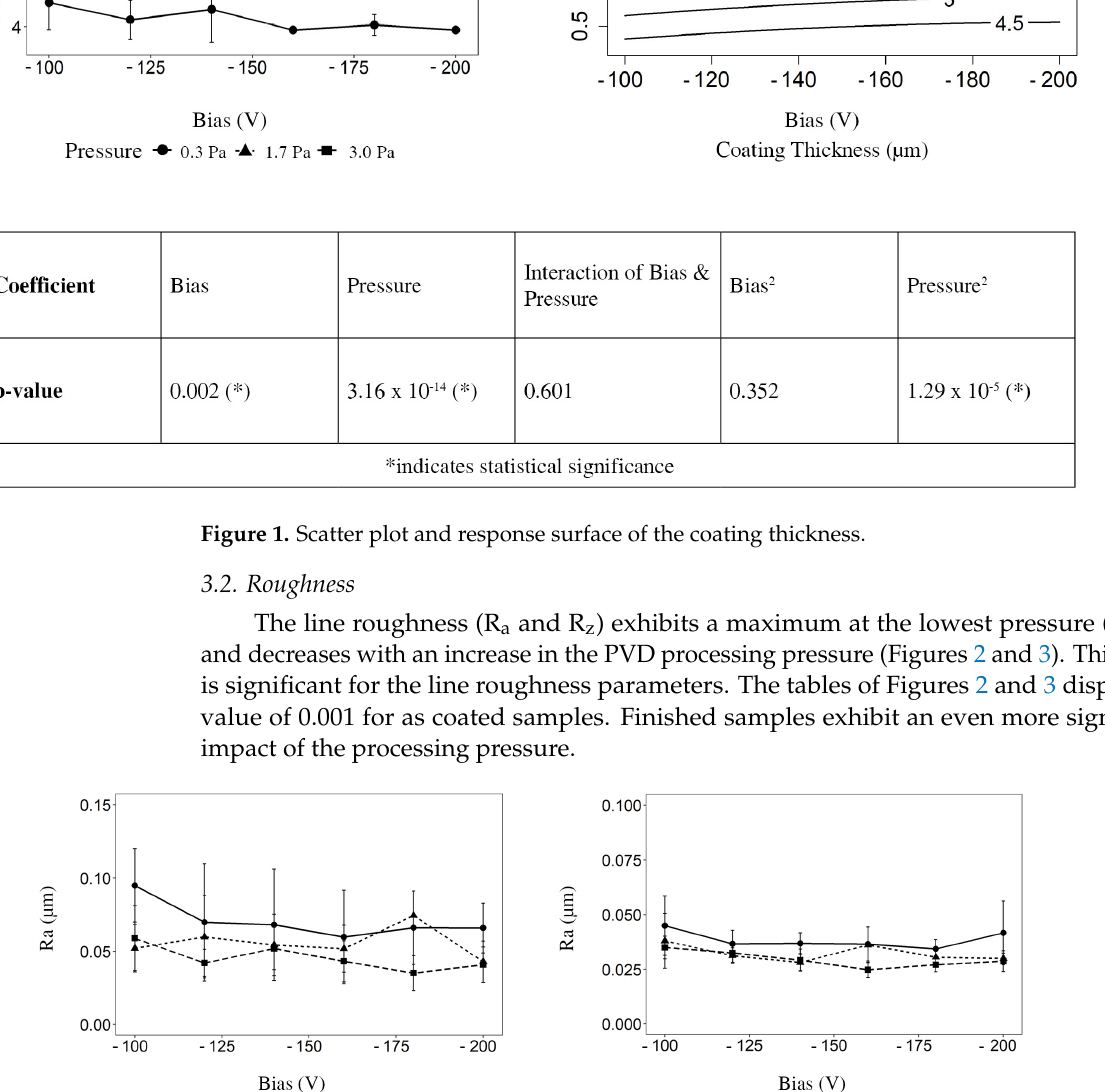
Figure 2. Scatter plots and response surface of the line roughness Ra as coated and finished.